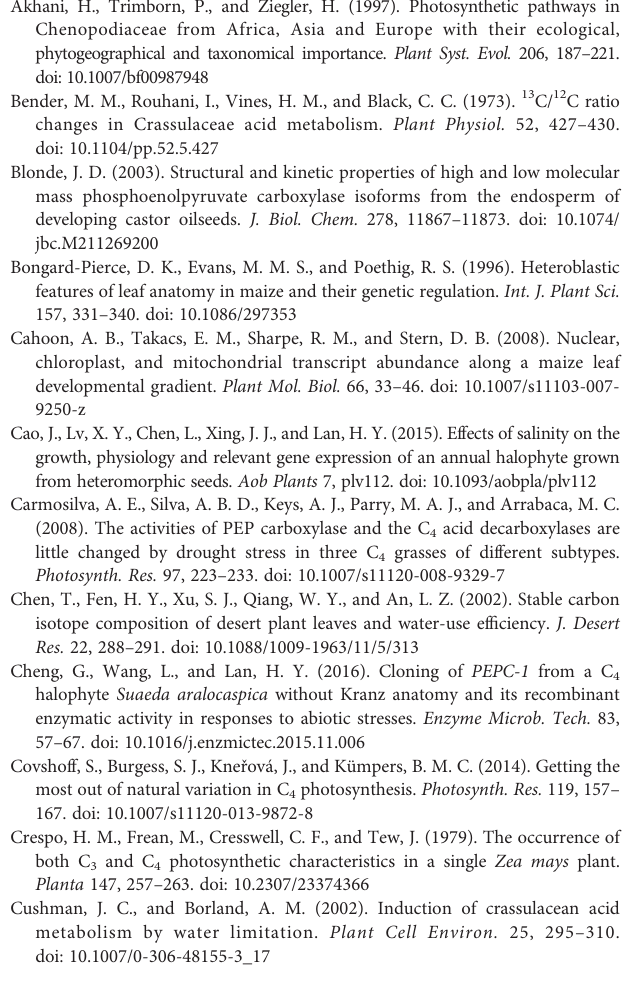
Scale bar is 1 cm.